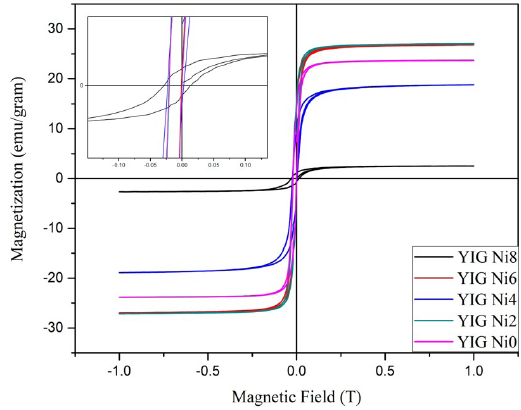
Fe Ni O (x= 0.00, 0.02, 3 5-x x 12